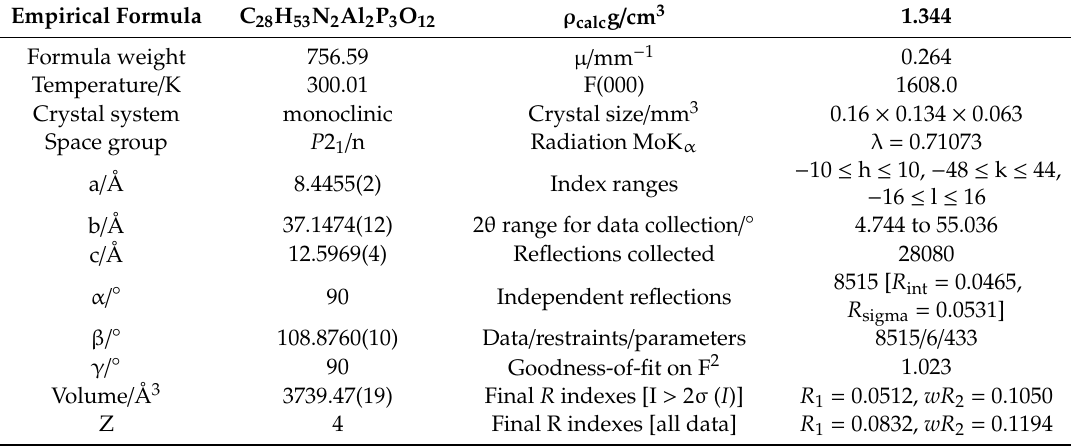
Table 2. Crystal data and structure refinement for SYSU-6.